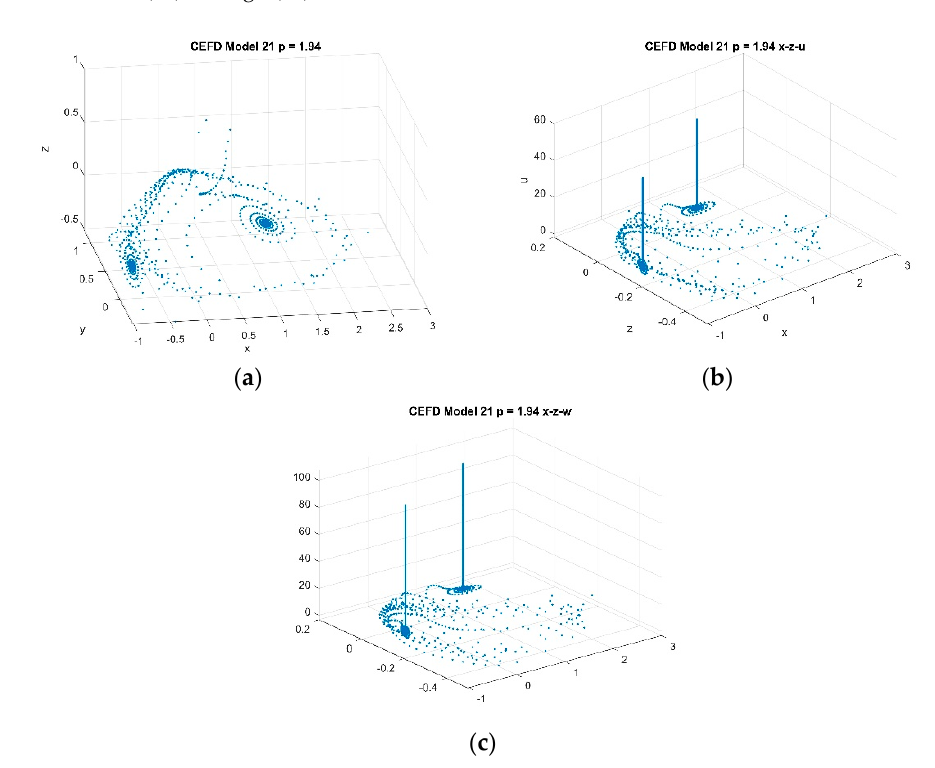
Figure 17. Model (21) phase portraits ( a ) x − y − z , ( b ) x − z − u , and ( c ) x − z − w at k = 2, p = 1.94, 𝛼 (cid:2873) = 0.3 .